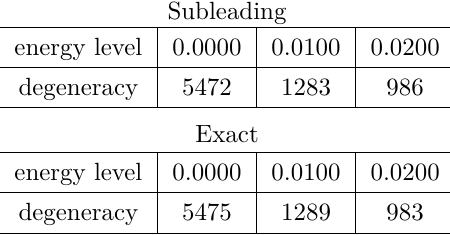
Table 3 . The tables present the degeneracies of dominating energy levels in spectra shown in figure 4, which are calculated with parameters n T = 399004 and N = 200000 . Data for the subleading order action is shown in the table upper, while that for the exact action is shown in the table